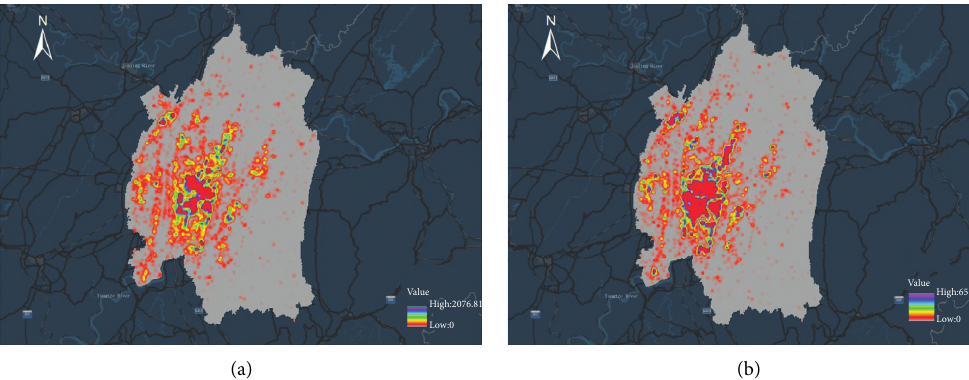
Figure 1: Heat map of where commuters reside and where they work. (a) Heat map of population distribution in the place of residence. (b) Heat map of the population distribution of the workplace.